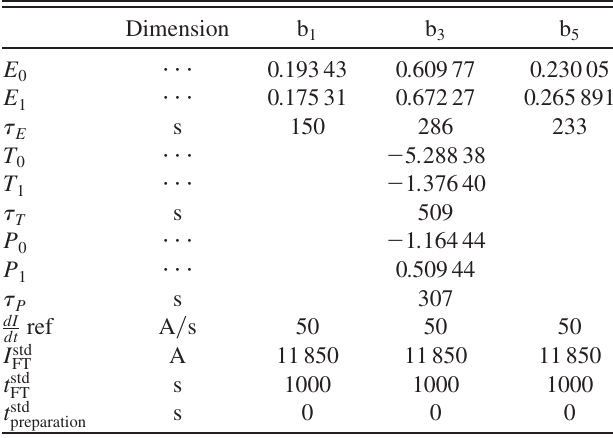
TABLE I. The fitting parameters of Eq. (2). Dimension